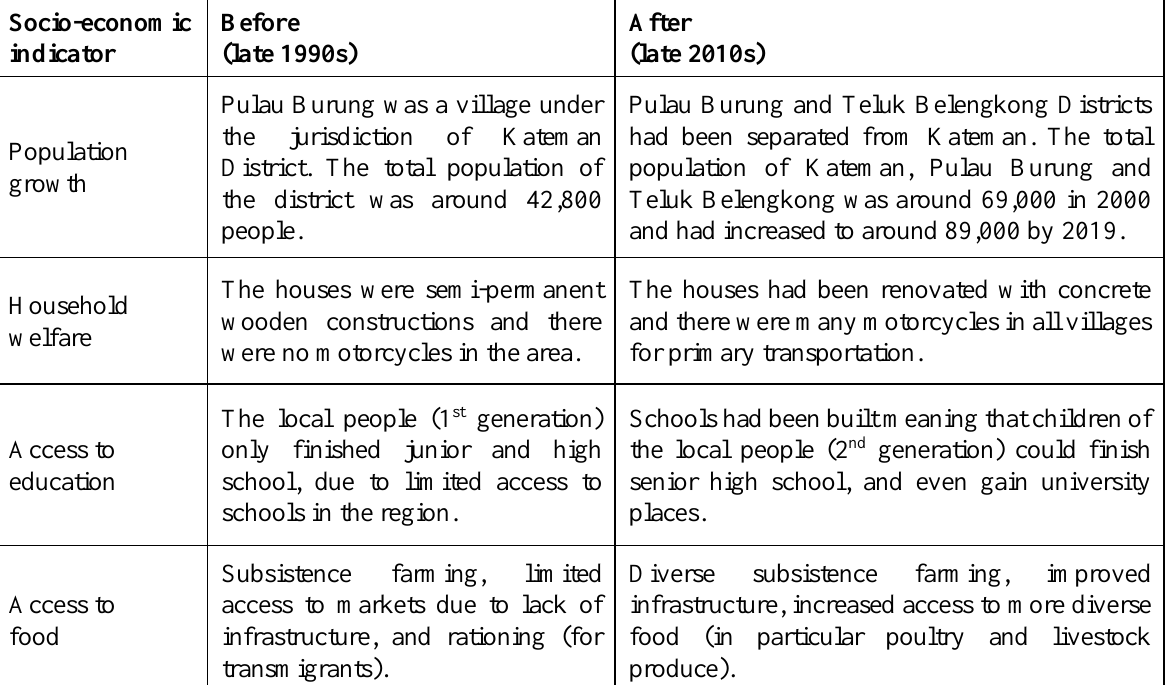
Table 1. Comparison of socioeconomic indicators in Pulau Burung before and after the arrival of coconut agroindustry. Population data were obtained from statistical records (BPS 2010, 2019a, 2019b; Rahmasary et al . 2020), and the remaining three indicators summarise information provided directly by local